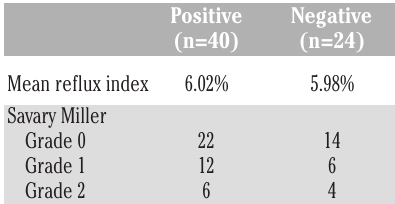
Table 4. Endoscopic esophagitis and reflux index according to Helicobacter pylori sta- tus at